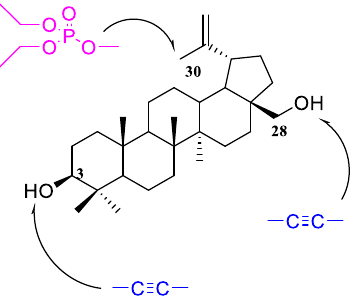
Figure 1. Schematic structure of target compounds.